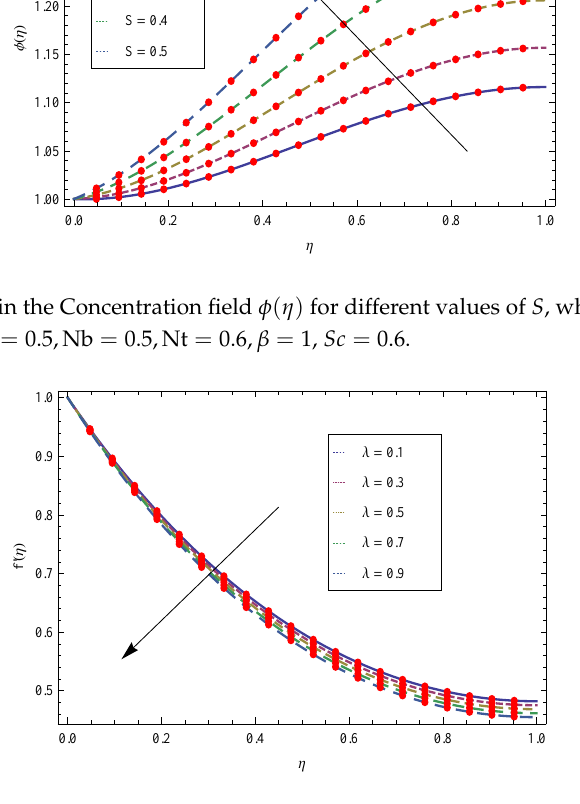
Figure 8. The effect of λ on f (cid:48) ( η ) , when h = − 0.25, kr = 0.7,Pr = 0.5,Ec = 0.5,Nb = 0.5,Nt = 0.6, β = 1, Sc =